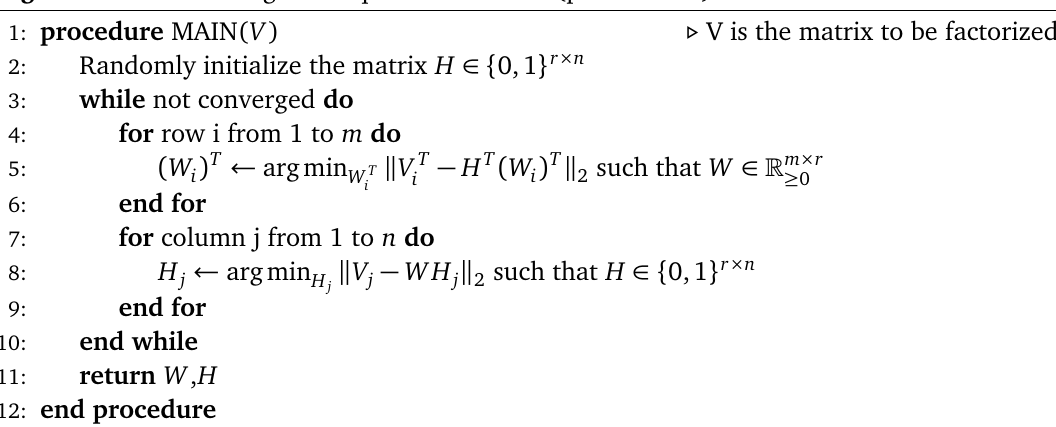
Algorithm 1 Alternating least squares for NBMF